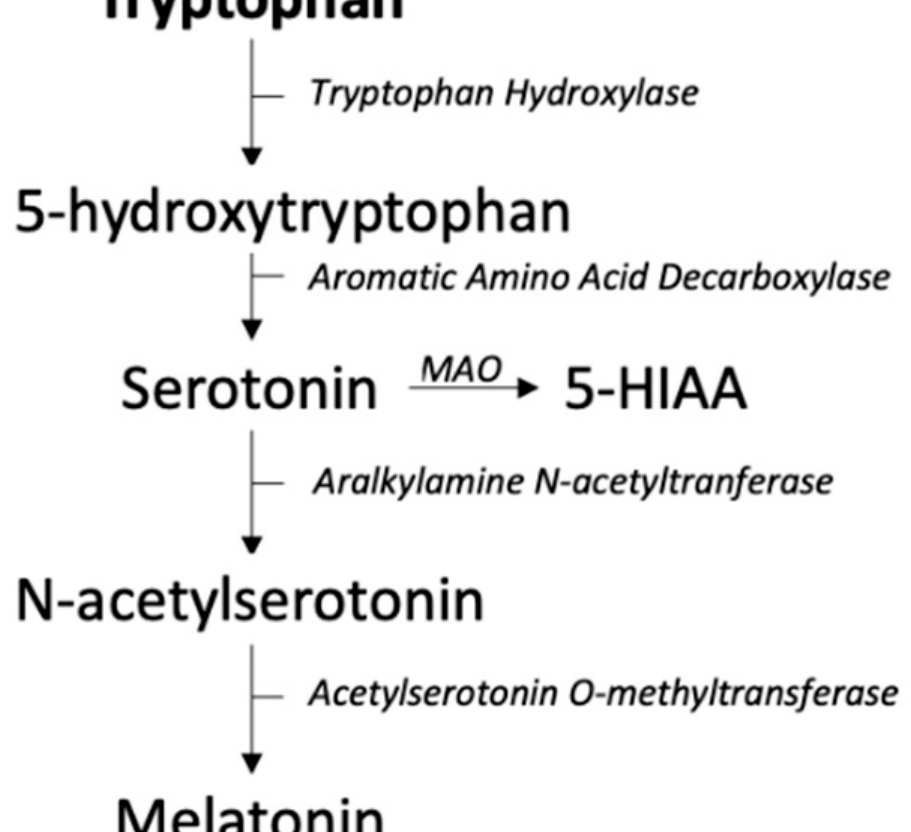
Figure 5. Serotonin pathway. Abbreviations: 5-HIAA; 5-hydroxyindoleacetic acid, MAO; monoamino oxidase.